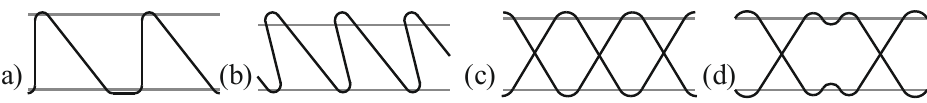
Figure 1. Lattice girder types approved for fatigue in semi-precast slabs ( a – c ) and element walls ( a , d ). The type of lattice girder shown in Figure 1a is approved to resist interface shear and vertical shear in semi-precast slabs and element walls. Due to the 90° inclination of every second bar (vertical) and the other bar being inclined (diagonal) towards the support (45° ≤ α ≤ 90°, Figure 2), all bars can be utilized for interface shear design. Additionally, in cases where such a lattice girder complies with the construction rules of shear reinforcement and has sufficient depth for adequate anchorage of all vertical and inclined bars within the compression zone, these bars can be considered for vertical shear design.